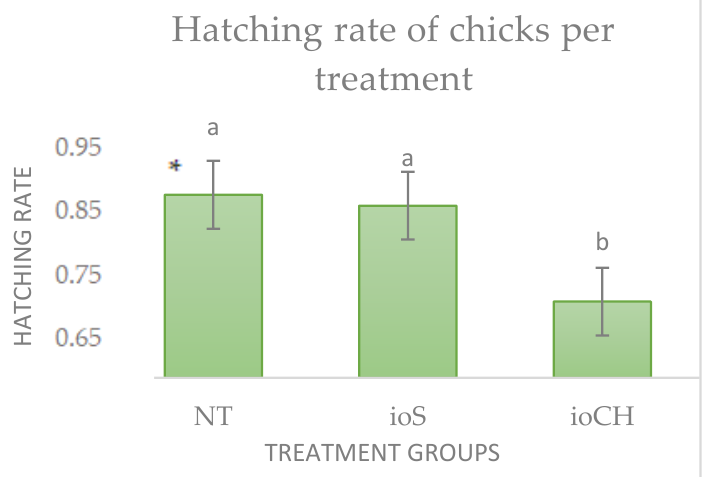
Figure 2. Distribution of hatched chicks by treatment ( p < 0.001) and sex ( p < 0.001): NT, control group; ioS, in ovo saline (NaCl); ioCH, in ovo carbohydrate solution. * Error bars represent standard deviations. Different letters (a, b) represent significant differences among treatment groups.